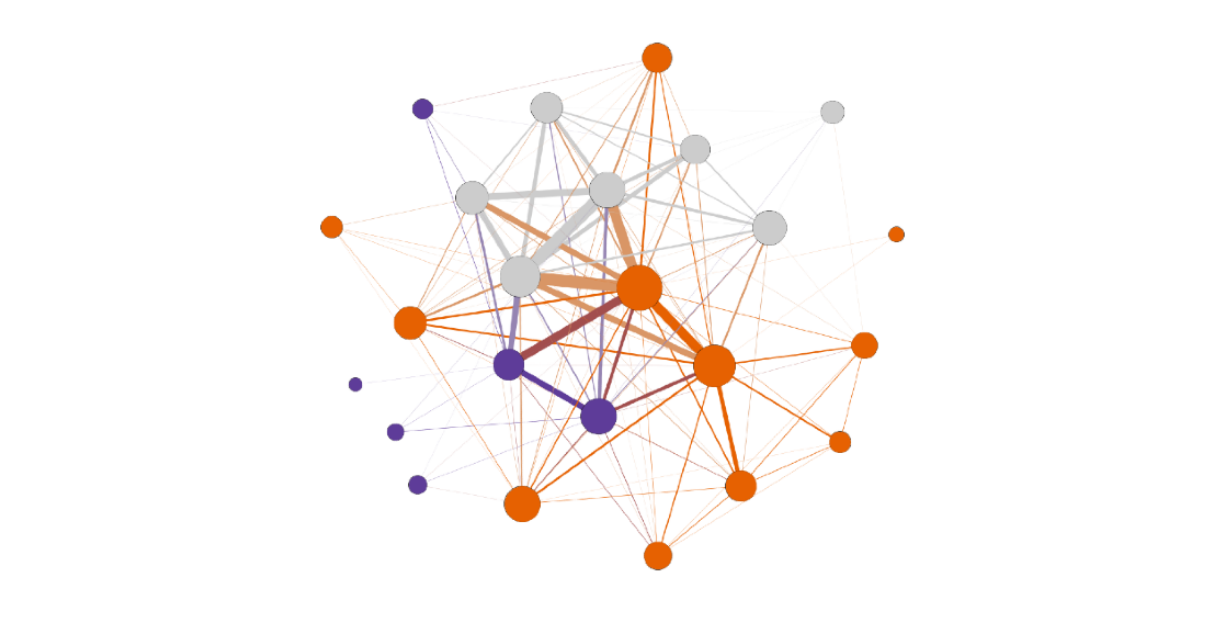
Figure 1. Network structure of social interactions where all types of social supports were exchanged. Node size indicates degree and node color indicates the existence of three subcommunities or groups, with one larger subcommunity shown in orange and two smaller subcommunities shown in purple and grey. Further, edge thickness represents the frequency of interactions when members communicated more